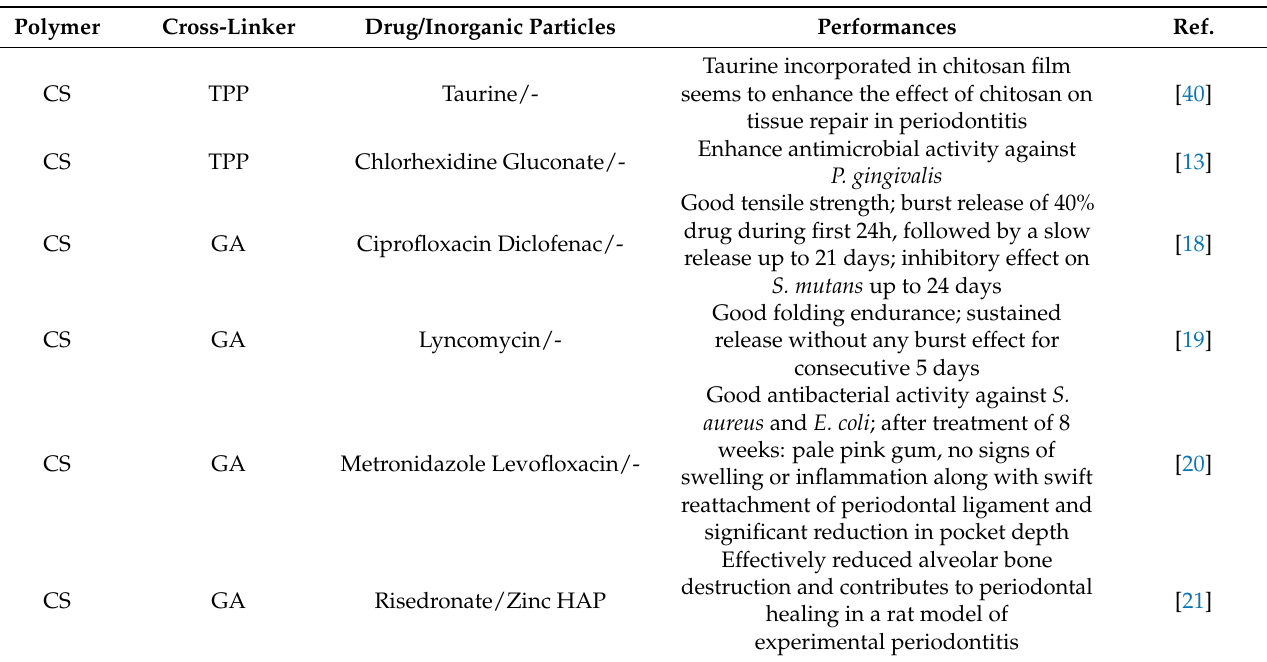
Table 4. Film as intrapocket drug delivery system for the treatment of periodontitis.